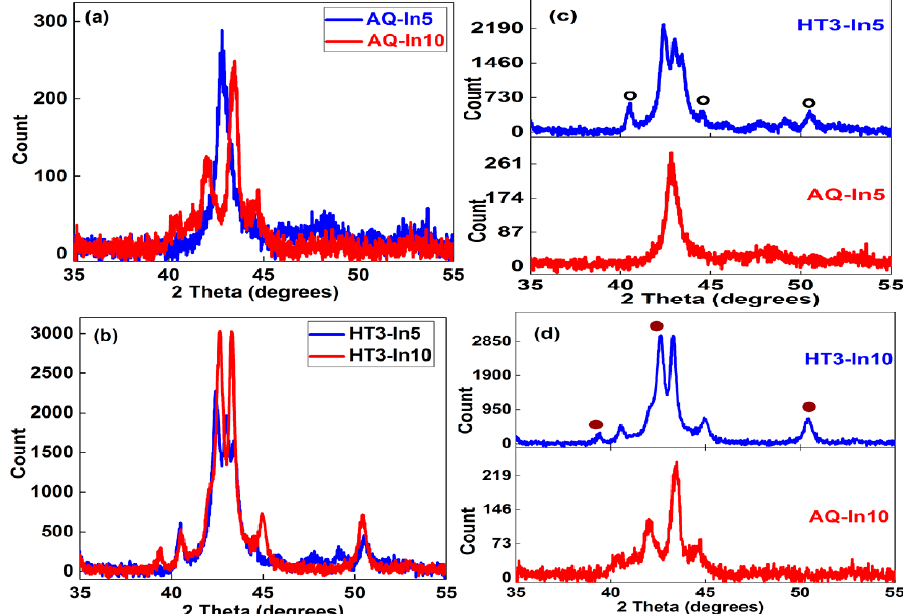
Figure 1. XRD patterns of AQ-In5/AQ-In10 ( a ), HT3-In5/HT3-In10 ( b ), AQ-In5/HT3-In5 ( c ), and AQ-In10 /HT3-In10 ( d ) samples, in the 2 θ range of 35–55 ◦ , showing the effect of the composition and/or heat